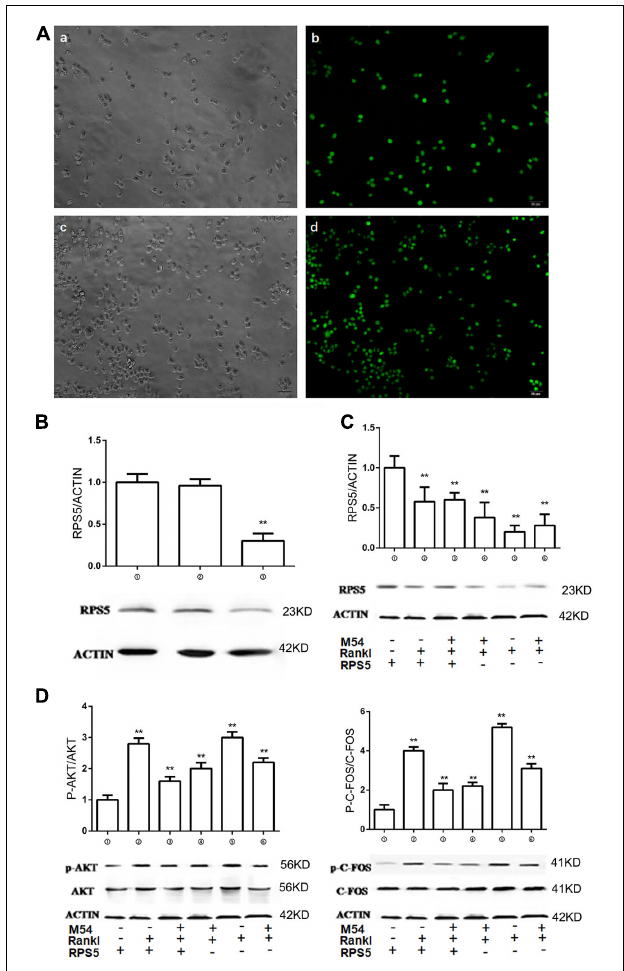
FIGURE 4 | RPS5 partially ameliorate the effect of M54. (A) Fluorescence of cells infected with lentivirus after 72 h. a, b was infected with Lv-NC and c, d was infected with Lv-shRNA-RPS5. (B) Detection of intracellular RPS5 protein expression, MOI = 20. (C) RPS5 expression in lentivirus infected RAW264.7 with or without M54 treatment (1 µ M). (D) Phosphorylation of AKT and C-FOS. (cid:172) RAW264.7 cells infected with Lv-NC; (cid:173) RAW264.7 cells infected with Lv-NC and induced with M-CSF, RANKL and PBS; (cid:174) RAW264.7 cells infected with Lv-NC, induced with M-CSF, RANKL and treated with 4 µ M M54; (cid:175) RAW264.7 cells infected with Lv-shRNA-RPS5; (cid:176) RAW264.7 cells infected with Lv-shRNA-RPS5 and induced with M-CSF, RANKL and PBS; (cid:177) RAW264.7 cells infected with Lv-shRNA-RPS5, induced with M-CSF, RANKL and treated with 4 µ M M54 ( ∗∗ P < 0.01, ∗ P < 0.05 vs. (cid:173) ).